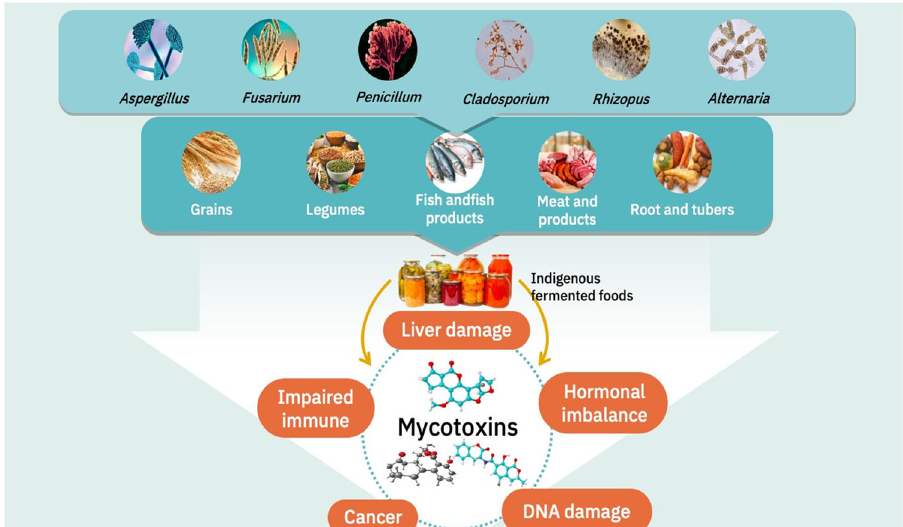
Fig. 1 Mycotoxin contamination in indigenous fermented foods and health implications on human. Illustrations adapted from Adobe stock images (http://stock.adobe.com/) under Standard Licensing.